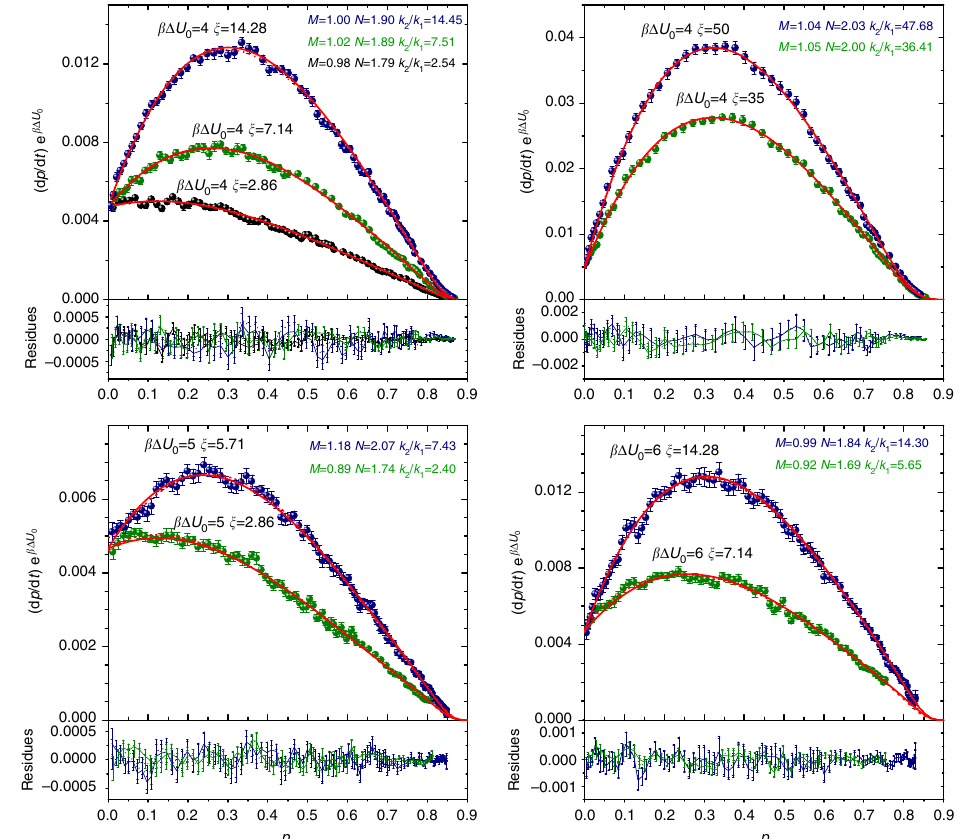
Fig. 6 Description of the autocatalytic kinetics. The p dependence of the rate d p /d t (scaled by e (cid:2) β Δ U 0 to facilitate comparison) at different autocatalytic strengths ξ and initial energy barriers β Δ U 0 . The solid lines are the predicted kinetics, i.e., d p /d t = k overall (1 − p ) 2 where k overall = (1/ k chem + 1/ k diff ) − 1 , with k k D ( p ) obtained from the mean-squared displacement. All the parameters are known from non-autocatalytic chem and diff given by Eqs. 2 and 4, and using reactions. The dotted lines (in some cases they cannot be distinguished from the solid lines) represent the best- fi t of the simulation data with k chem replaced by the Kamal ’ s rate constant, i.e., k chem = ( k 1 + k 2 p M )(1 − p ) N − 2 with k 1 , k 2 , M , and N free-parameters independent of p . The values of M , N , and k k 2 / 1 associated to each dotted line is indicated. Below each frame, in the same color as the symbols, the residues with respect to the predicted kinetics are shown as solid lines, and with respect to the best- fi tted Kamal equation as dotted lines. Different panels refer to different values of β Δ U